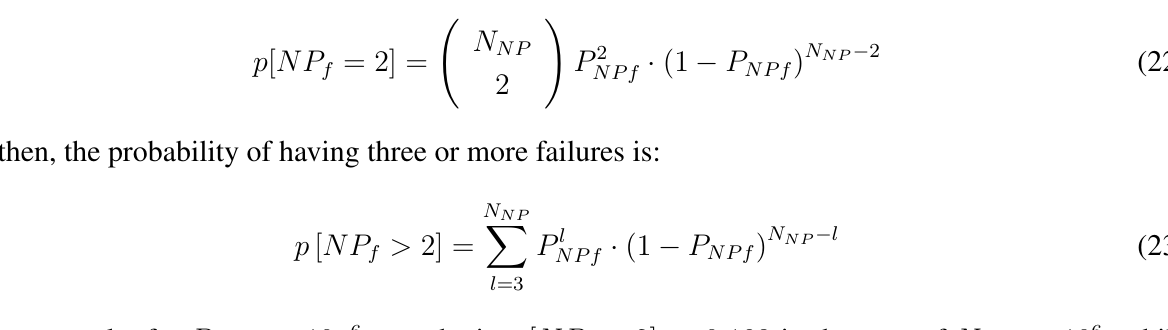
Figure 6. Probability of having two failed nanoparticles out of a flow of N = 10 7 (circle) and N (asterisk), N NP